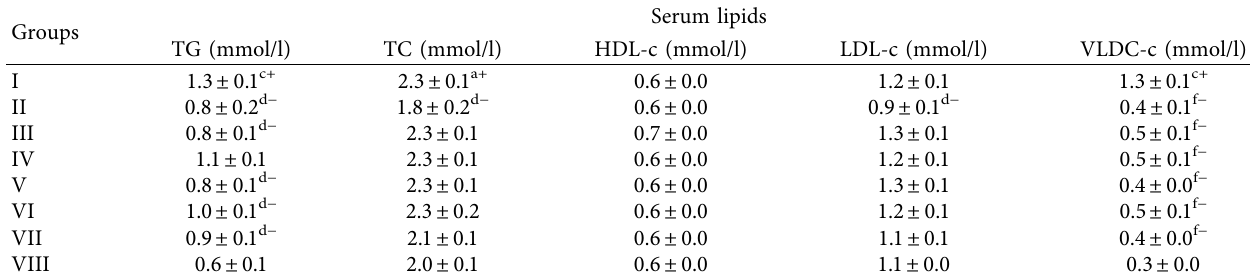
Table 10: Effect of 50–400mg/kg/day of CVE on the serum lipid profile of DOX-treated rats. Groups